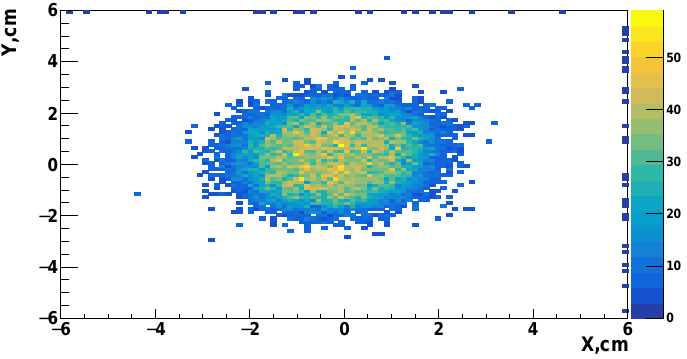
Figure 2. Reconstructed spot of the carbon ion beam in the target position, empty target.